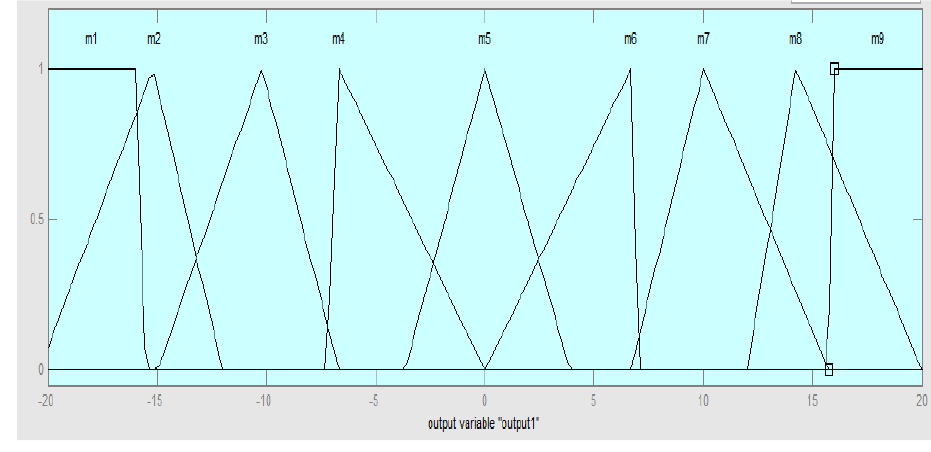
Fig. 6. Membership function for, (a) input variable, (b) output variable.